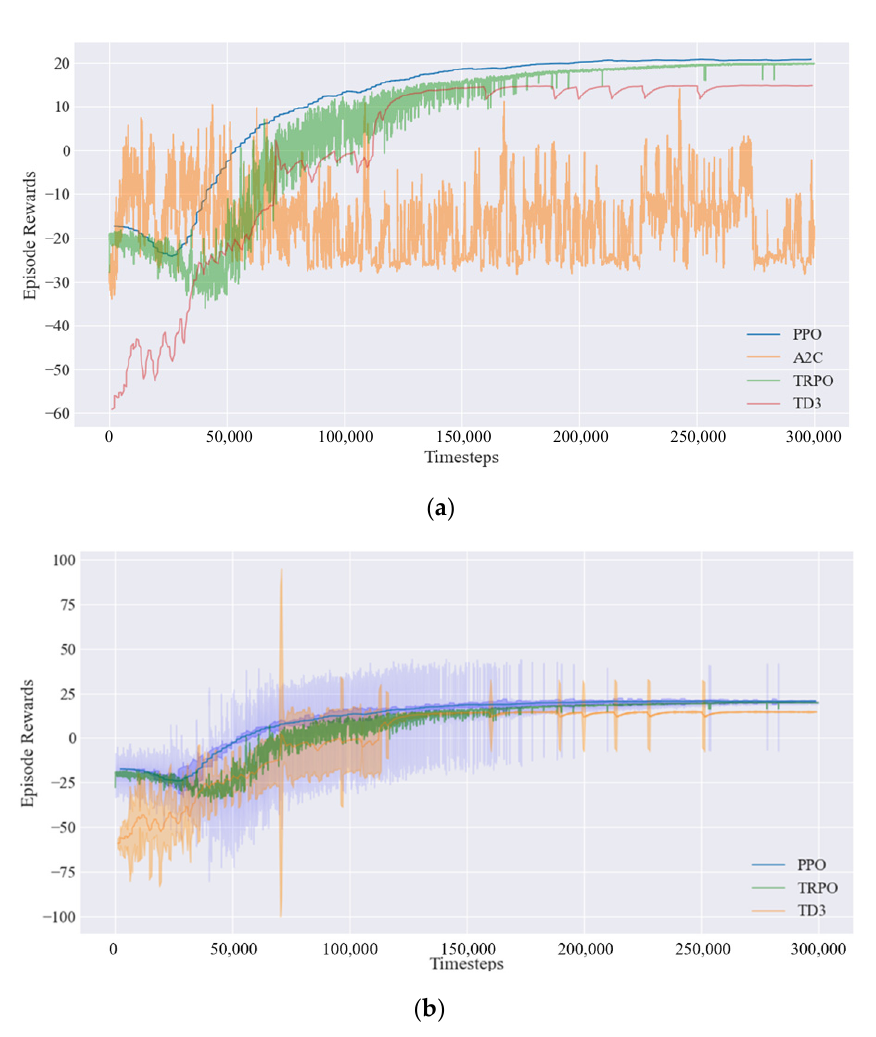
Figure 6. Convergence curves for the reconnaissance HVT scenario. ( a ) The convergence curves of three algorithms. ( b ) The convergence curves of two algorithms. The shaded region denotes the standard deviation of average evaluation over three trials.